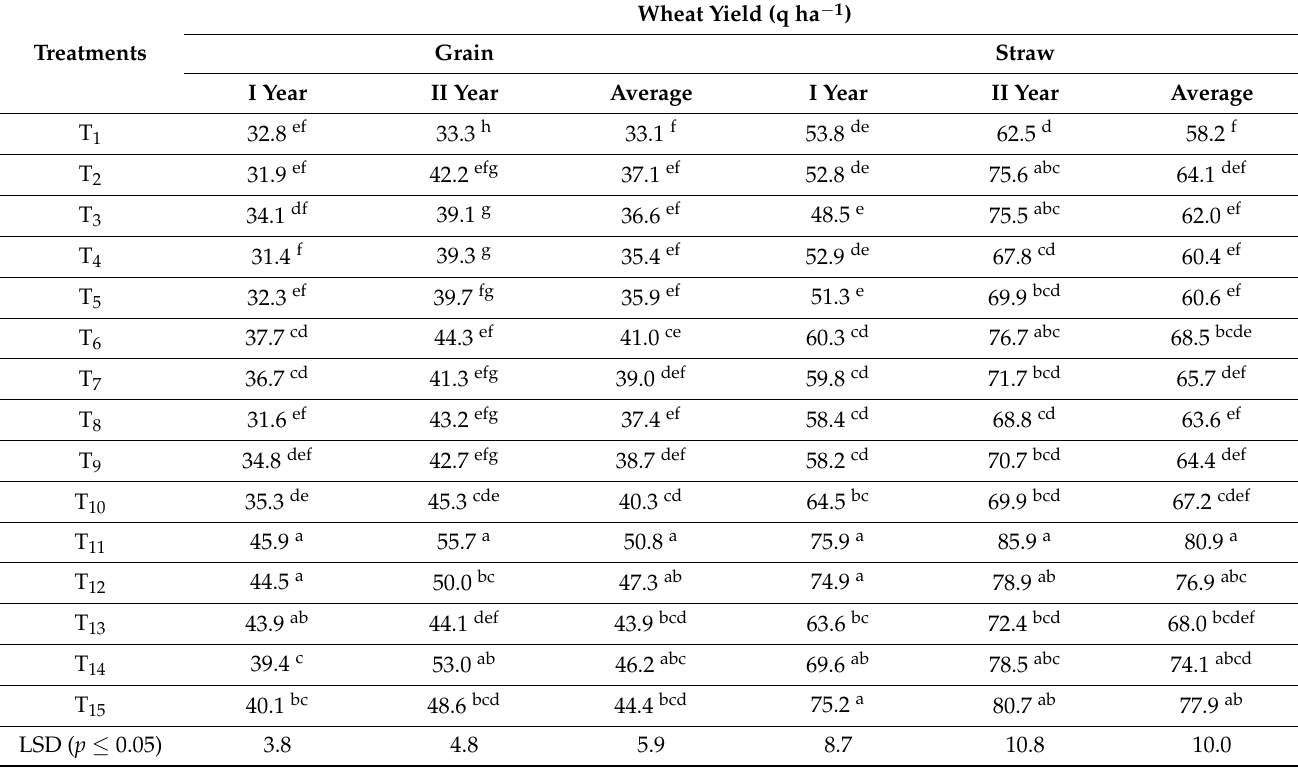
Table 3. Effect of different fertilizers and manures on grain and straw yield of